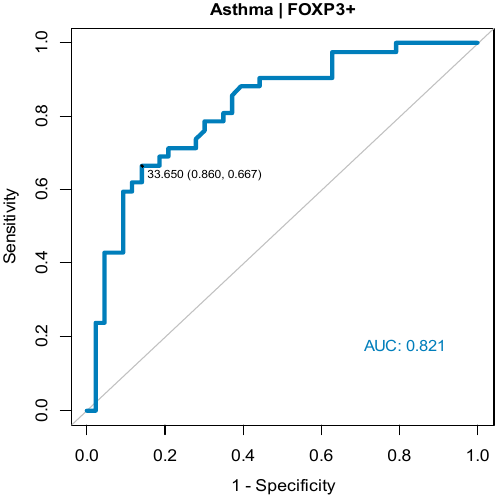
Figure 2. ROC curve predicting asthma risk based on FOXP3 level.